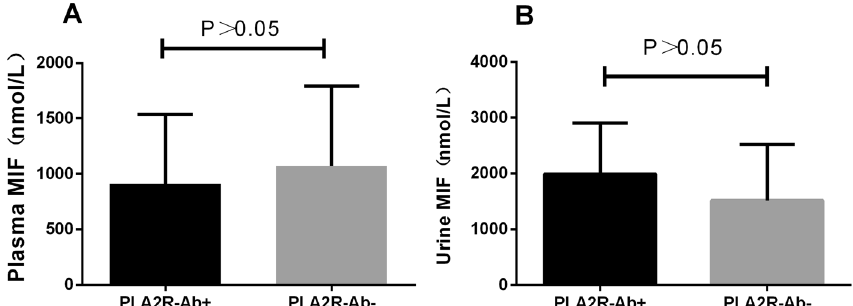
Figure 2. ( A ) Comparison of PLA2R-Ab-positive (n = 35) versus PLA2R-Ab-negative (n = 22) plasma MIF levels in patients with MN. ( B ) Comparison of PLA2R-Ab positive (n = 35) versus PLA2R-Ab negative (n = 22) urine MIF levels in patients with MN.